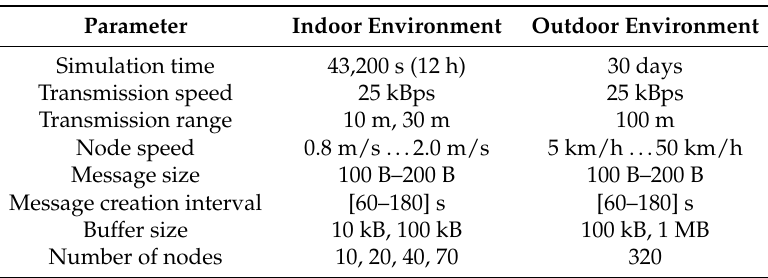
Table 2. Simulation